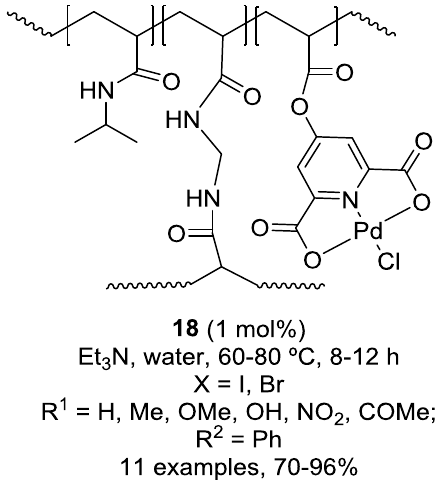
Figure 6. Immobilized palladium on PNIPAM-co-PPAP hydrogel as catalyst in the Sonogashira cross-coupling reaction. Conditions, substrate scope and yield range (Scheme 2).